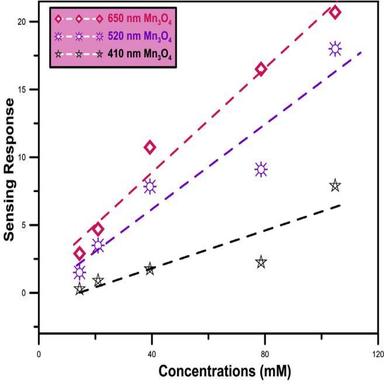
Sensitivity of each film thickness was calculated from current measurements for varying concentrations of artificial sweat (14.4 mM–104.8 mM). Thicker films result in more linear response.